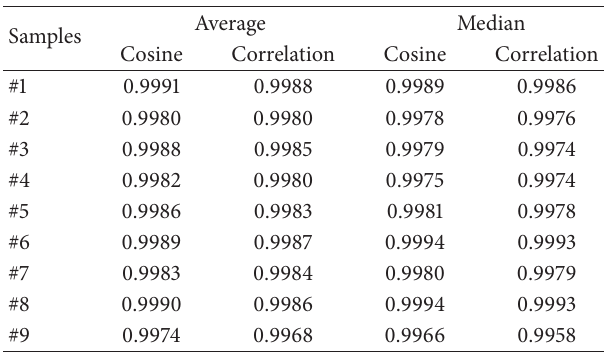
Table 4: The similarity of XRD fingerprints of nine Zuotai